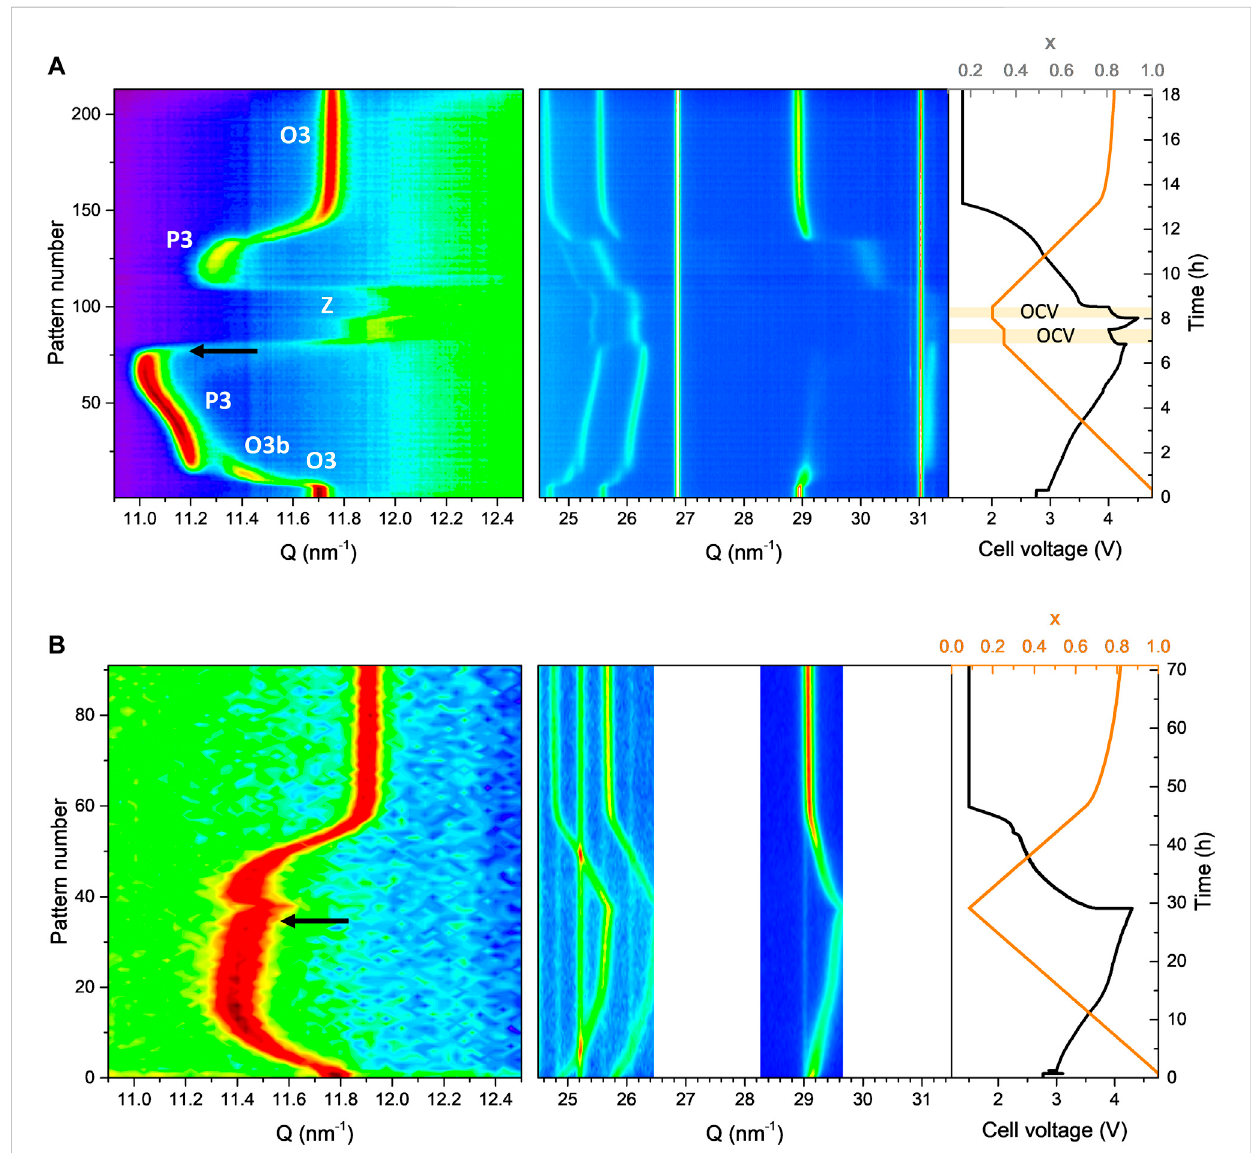
FIGURE 7 OperandoXRDtakenduringthe fi rstcyclechargeof (A) O3-NaNMFO-SSand (B) O3-NaNMFO-SG.Theblackarrowsindicatethemomentwhenthe (003) peak starts to shift to larger